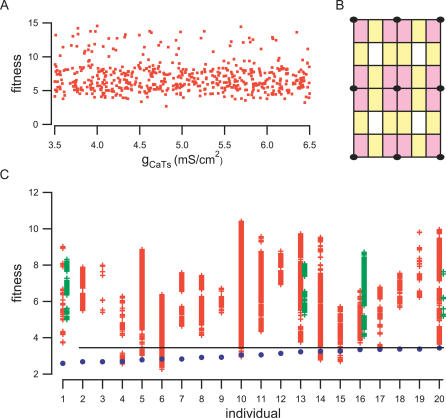
Comparison with other Methods(A) Fitness of hundreds of individuals obtained during the searching algorithm evolution, as a function of their gCaTs value and centered around the data value (equal to 5).(B) Parameter space simplified to a grid of three black points in two dimensions. All individual falling in a pink region will have just one close neighbor, all the points in yellow area will have two close neighbors, and all the points in a white area will have four close neighbors.(C) Depending upon individuals (blue circles), between eight and 4,096 close neighbors are found on a six-points-per-dimension grid. The fitnesses of all these neighbors are shown as red crosses. For some individuals which have neighbors with fitness values above 3.45 but below 4 a grid of ten points per dimension was also tested (green crosses).